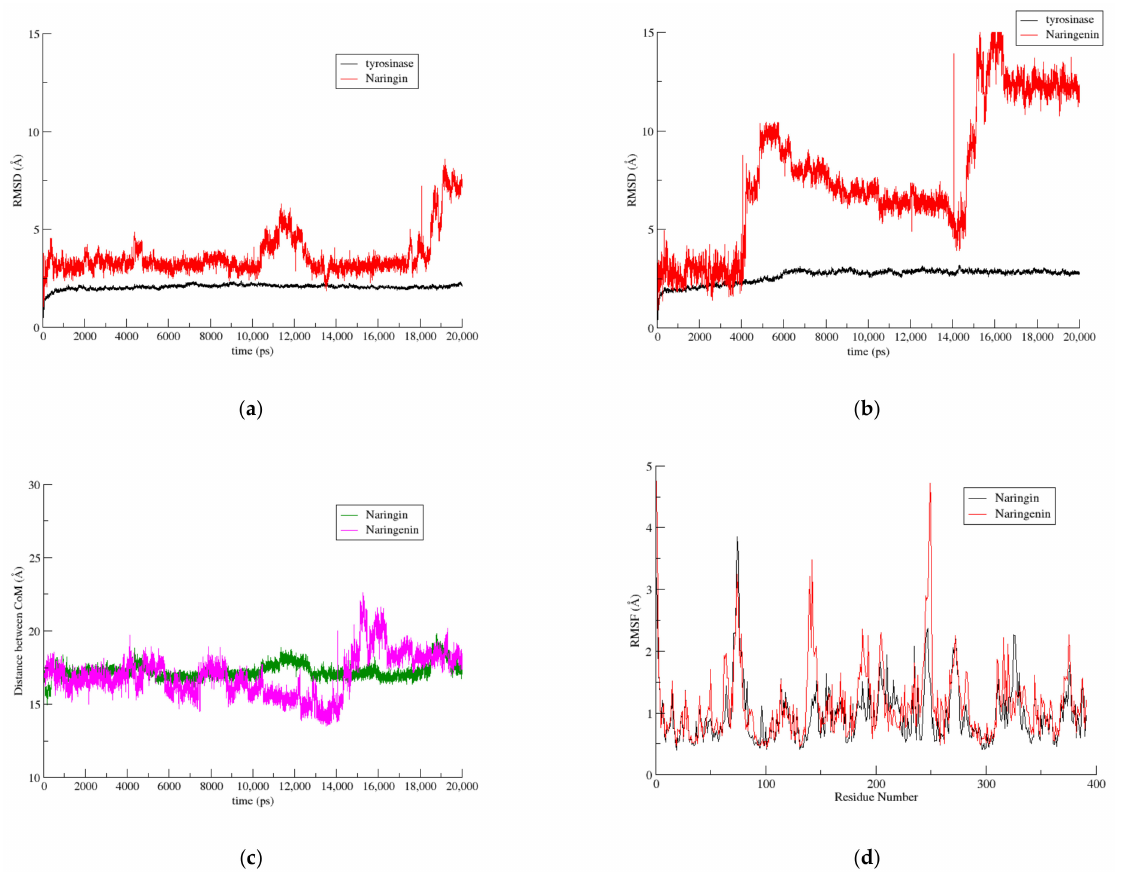
Figure 6. RMSD vs. time for all atoms in ( a ) naringin and ( b ) naringenin (aglycone) complexes with tyrosinase as a function of simulation time, ( c ) COM plot of tyrosinase in complex with naringin and narinengin, and ( d ) RMSF plot of tyrosinase residues in their complexes with naringin and